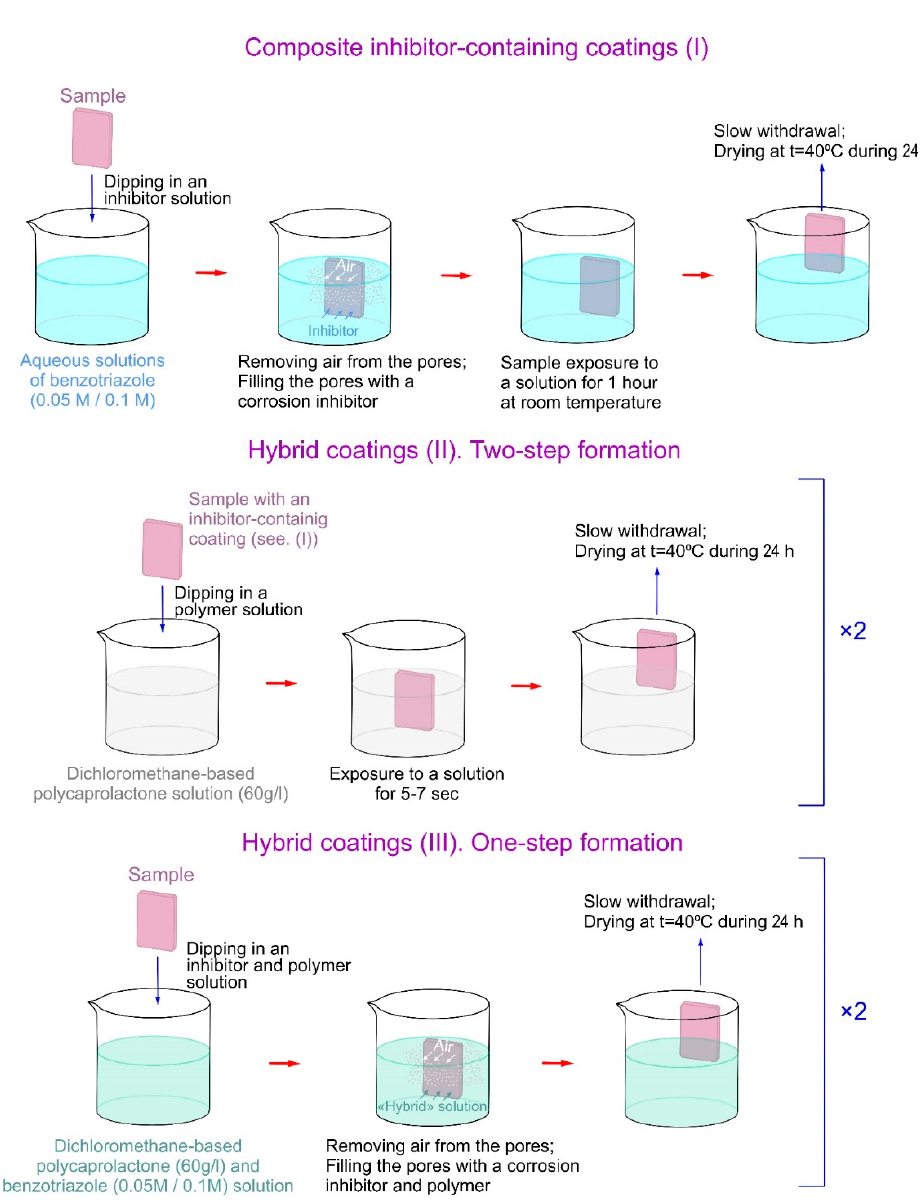
Figure 1. The scheme of the formation processes for various types of the studied